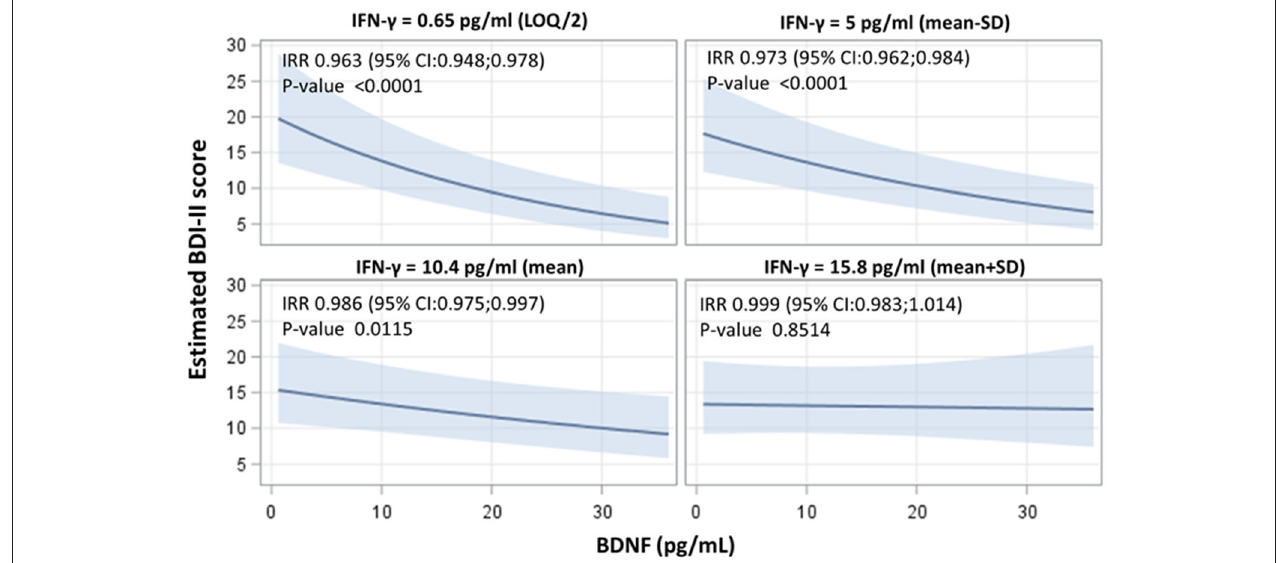
FIGURE 2 | Interactive effects of BDNF and IFN- γ on the BDI-II score, indicating the strength of association between BDNF concentrations and BDI-II score at four selected levels of IFN- γ (LOQ/2), mean - standard deviation ( SD ), mean and mean ± SD value). Adjusted incidence rate ratios (IRR) were reported for one unit increase in BDNF concentrations, at each IFN- γ level. IRR correspond to exp ( β ); BDNF, Brain-Derived Neurotrophic Factor; BDI-II, Beck Depression Inventory-II; IFN- γ , interferon gamma.